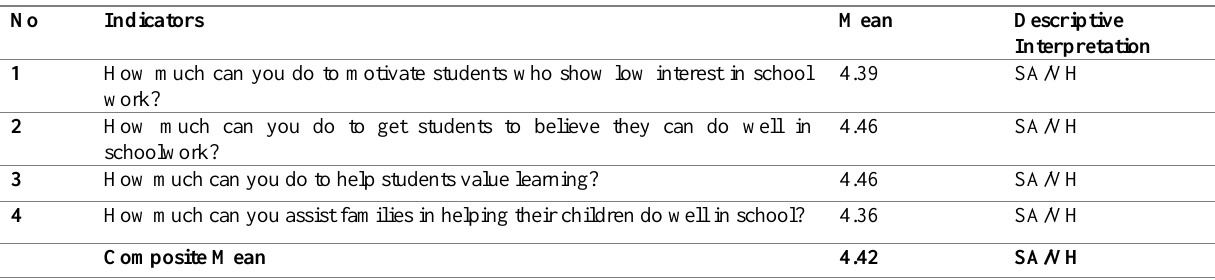
Table 1: Self-Efficacy in Student